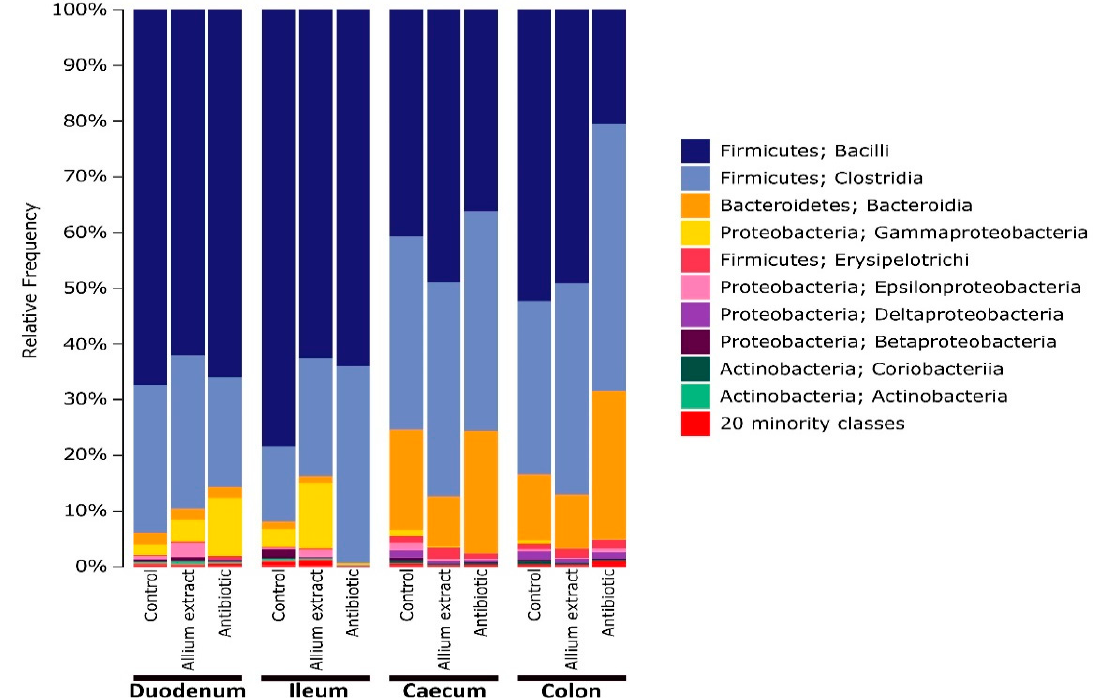
Figure 1. Microbial composition at class level of piglet gut microbiota grouped by gut region and treatment. Classes in the legend are sorted from most abundant to lowest abundant.